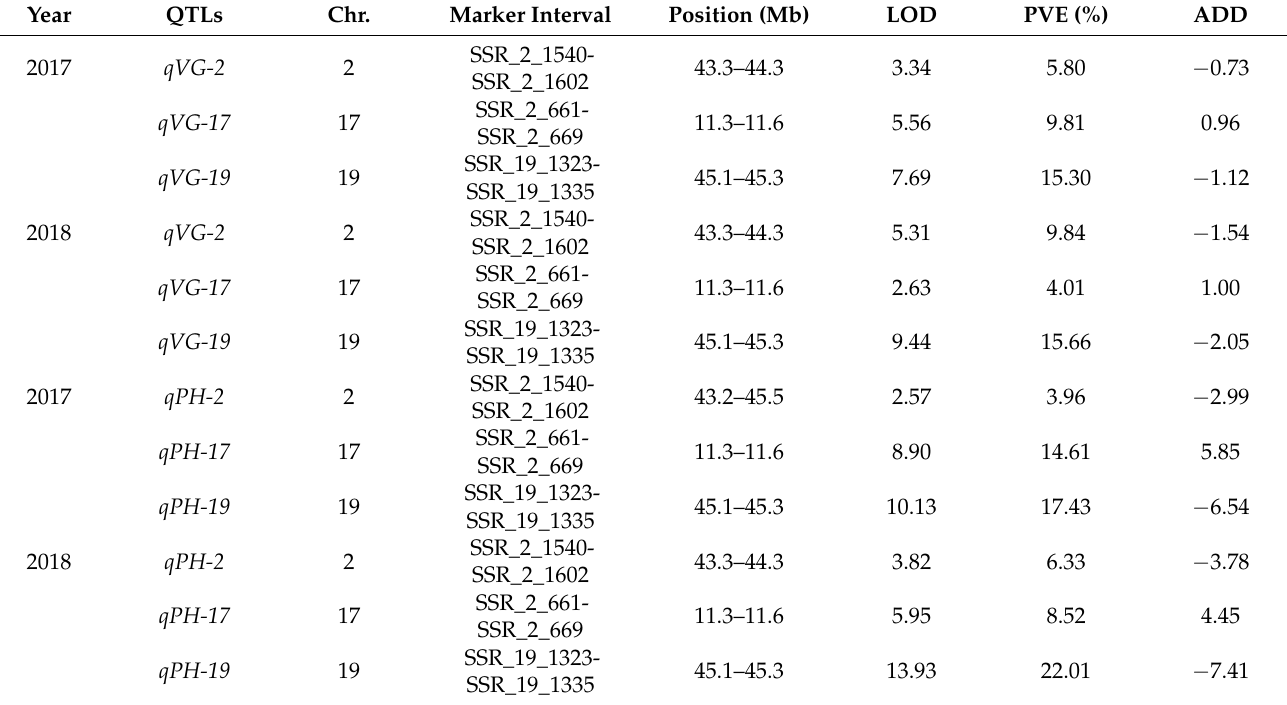
Table 1. QTLs statistics associated with VG and PH in the ZH39 × NY27-38 F 6